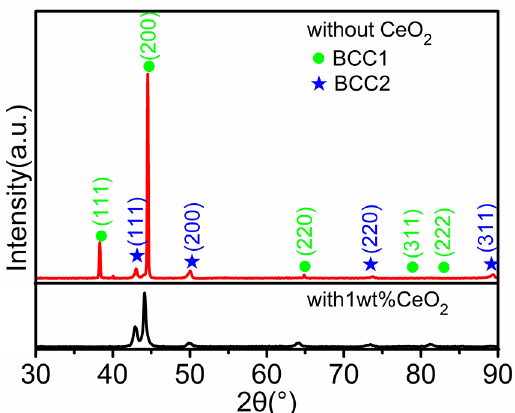
Figure 1. XRD patterns of AlCoCuFeMnNi without and with 1wt% CeO HEACs 2